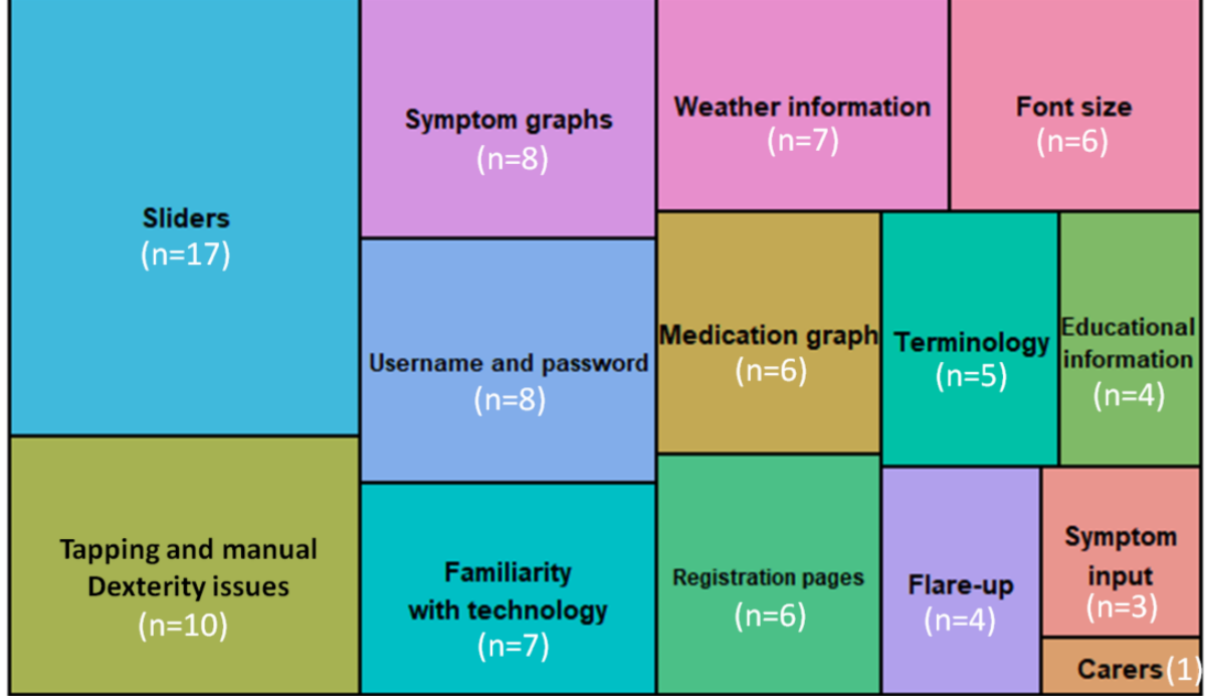
Figure 4. Treemap depicting the number of references made to each coded